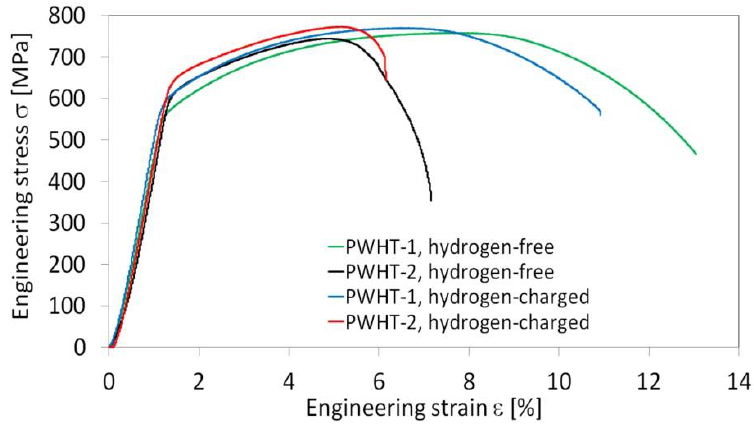
Figure 11. The effects of PWHT conditions and subsequent electrolytic hydrogenation on tensile deformation behavior of investigated T92/T92 weldments.